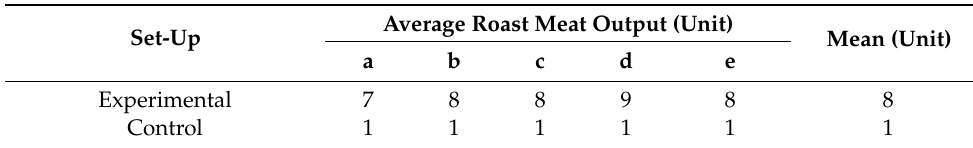
Table 15. Surplus roast meat output (experimental versus control set-up). Cooking Session Roast Meat Output Surplus (%) 1 600 2 700 3 700